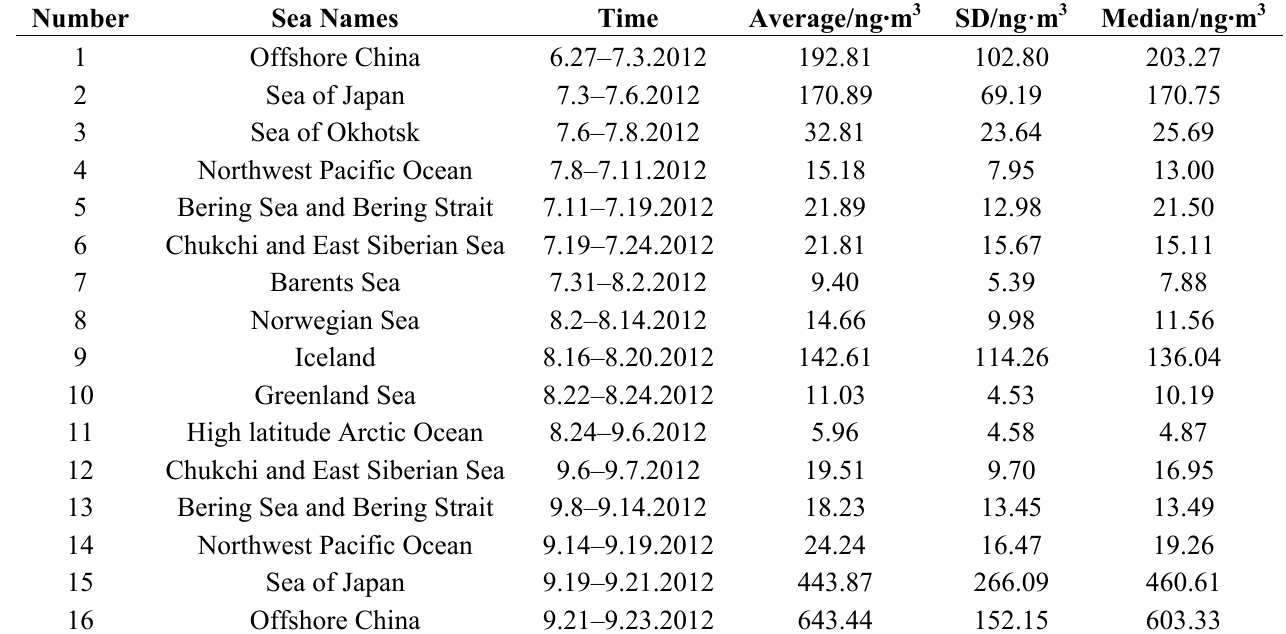
Table 1. Black carbon concentrations of different seas along the fifth CHINARE Arctic